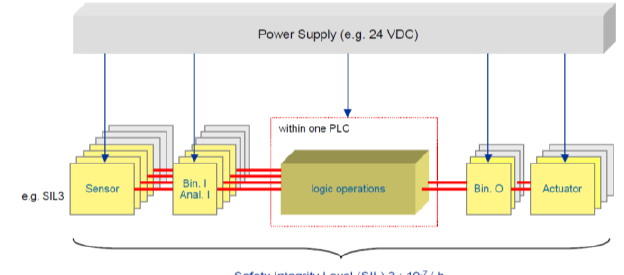
Fig. 3. Example of a safety function